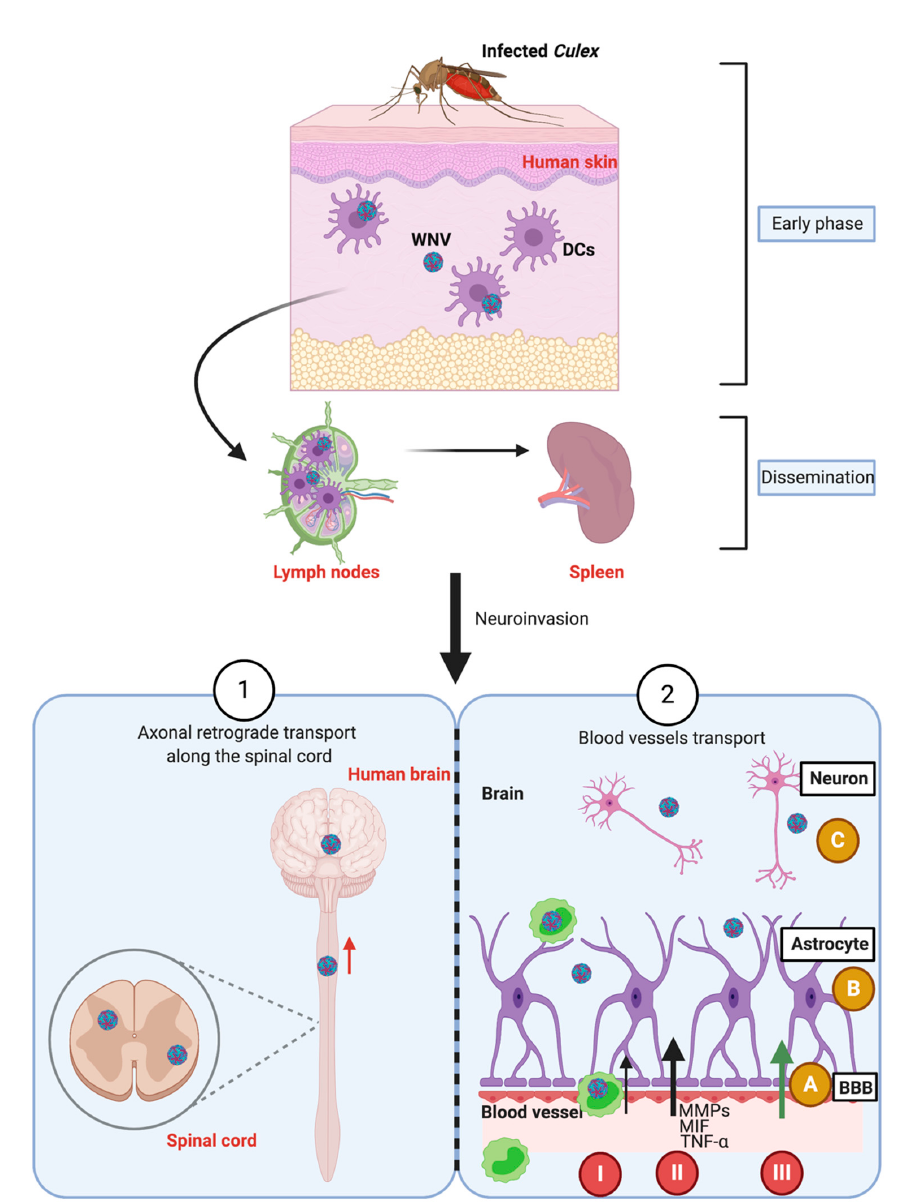
Figure 3. Dissemination steps of WNV in vertebrate hosts such as humans. At the early phase of infection, WNV disseminates in the human skin after a WNV-infected mosquito bite. First, replication begins in the keratinocytes and dendritic cells (DCs) and is followed by a migration of the WNV into the dermis. After that, DCs containing the WNV migrate to the lymph nodes where the WNV is amplified. Systemic viremia gives rise to infection of peripheral organ infection, such as the spleen. More severe infections lead to neuroinvasion by two possible routes. The first ( 1 ) consists of an axonal retrograde transport along the spinal cord [70]. The second ( 2 ) involves blood vessel transport and crossing over the blood–brain barrier (BBB). Three steps are required to mediate the neurovirulence in the brain by the blood route: ( A )—Crossing the BBB. ( B )—The virus interacts with the brain cells. ( C )—Infection of neurons. To cross the BBB, three methods are possible. ( I )—The first is a “Trojan horse” mechanism, in which the WNV is internalized into lymphocytes that are able to cross the BBB. ( II )—The second method is permeabilization of the BBB in response to TNF- α and MIF secretion. After MIF secretion by leucocytes, the MMPs are produced and increase the BBB permeability [51–54]. ( III )—The third is enhancement of virus attachment, probably dependent on E protein glycosylation, which permits transcellular passage (inspired by